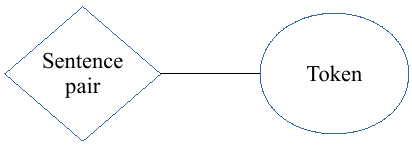
Figure 2. Scheme of the heterogeneous graph network.